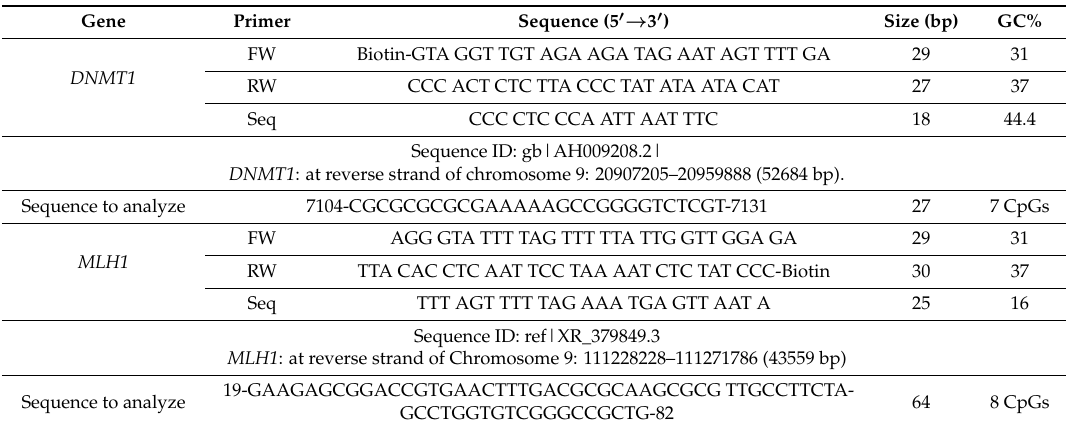
Table 1. Sequence to analyze and primers for CpG methylation